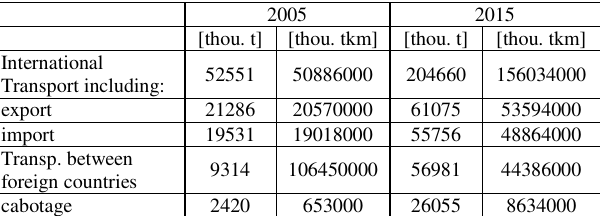
Table 1. Carriage and haulage work of the Polish international road transport in 2005 and in 2015 by the types of carriage [5] 2005